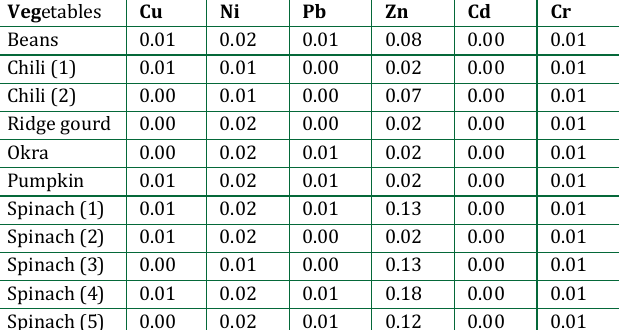
Table 8: Daily intake of metals kg/person/day.